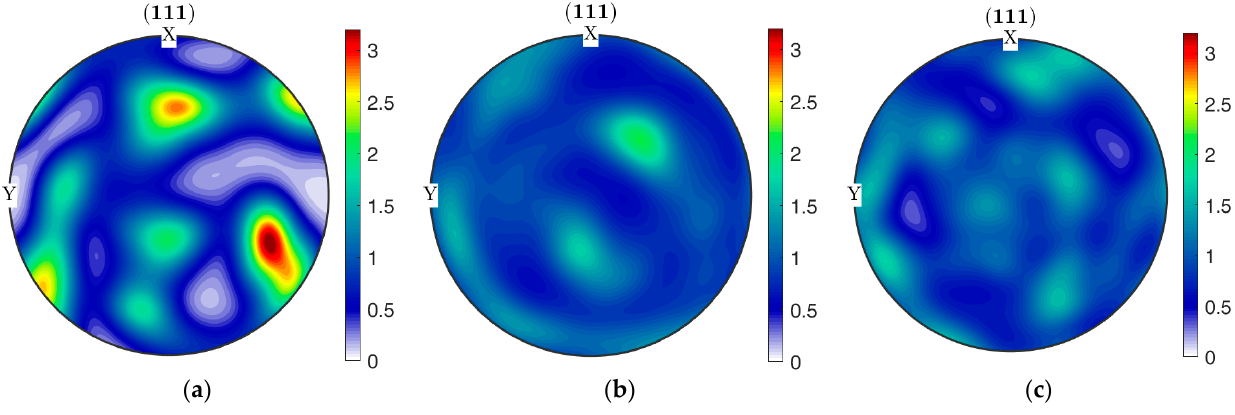
Figure 8. (111) pole figures for the UFG 6060 alloy produced by ( a ) HPT and after subsequent SP deformation at ( b ) 150 °C and ( c )180